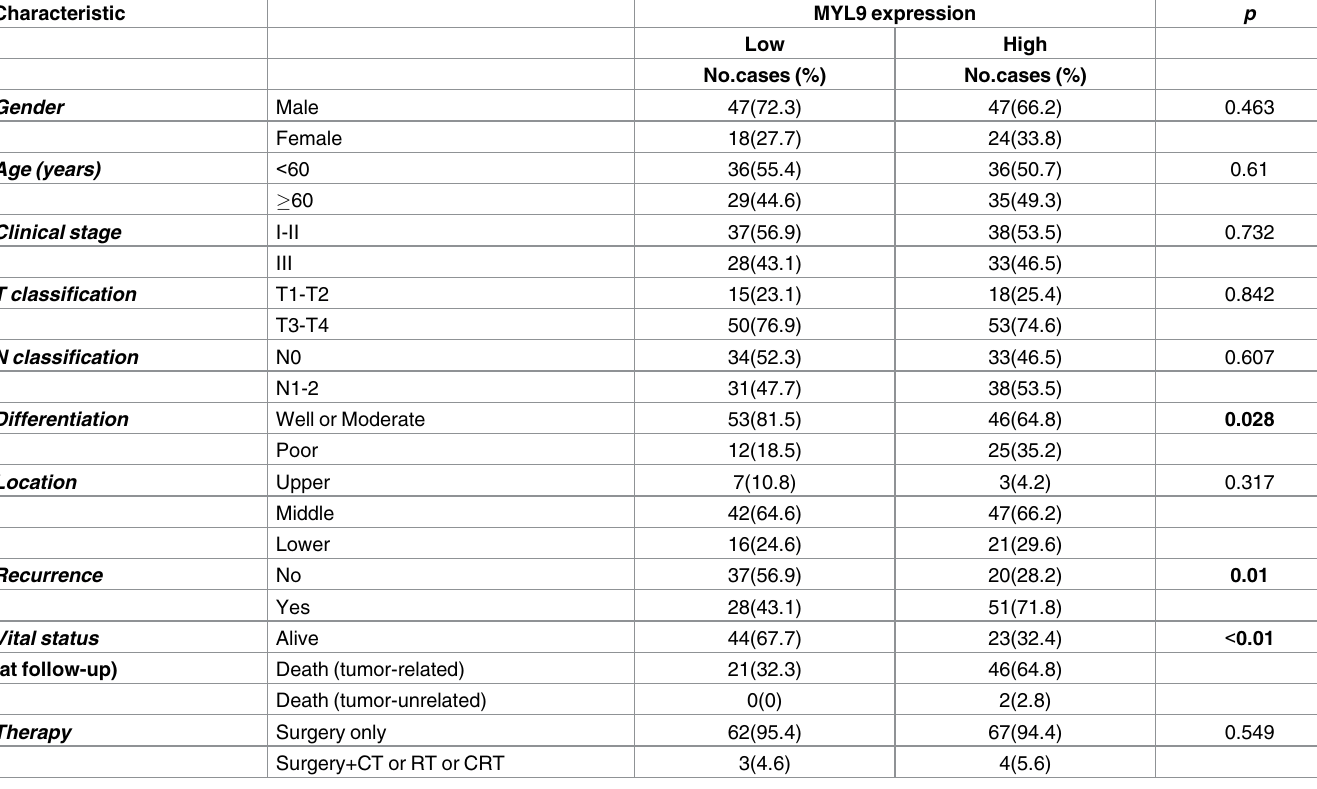
Table 2. Correlation between MYL9 expression and clinicopathological characteristics of ESCC.